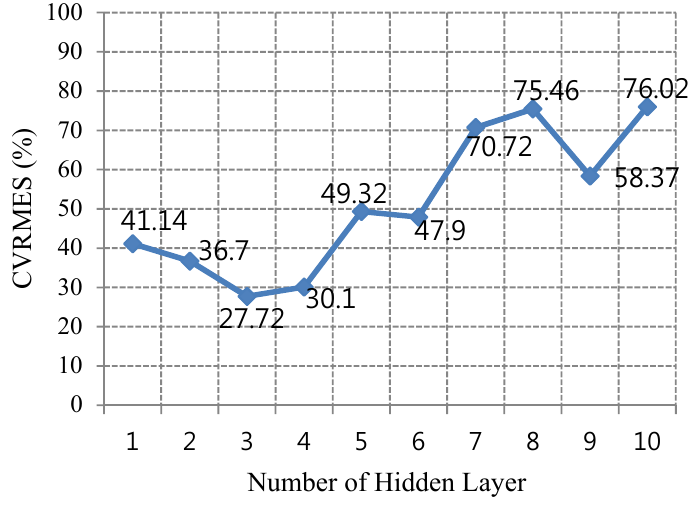
Figure 6. Mean bias error (MBE) by a different number of hidden layers.